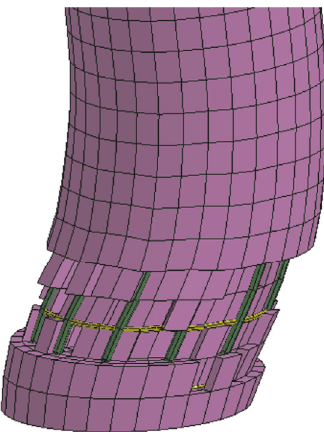
Figure 13: Failure mode of the pier of numerical model.